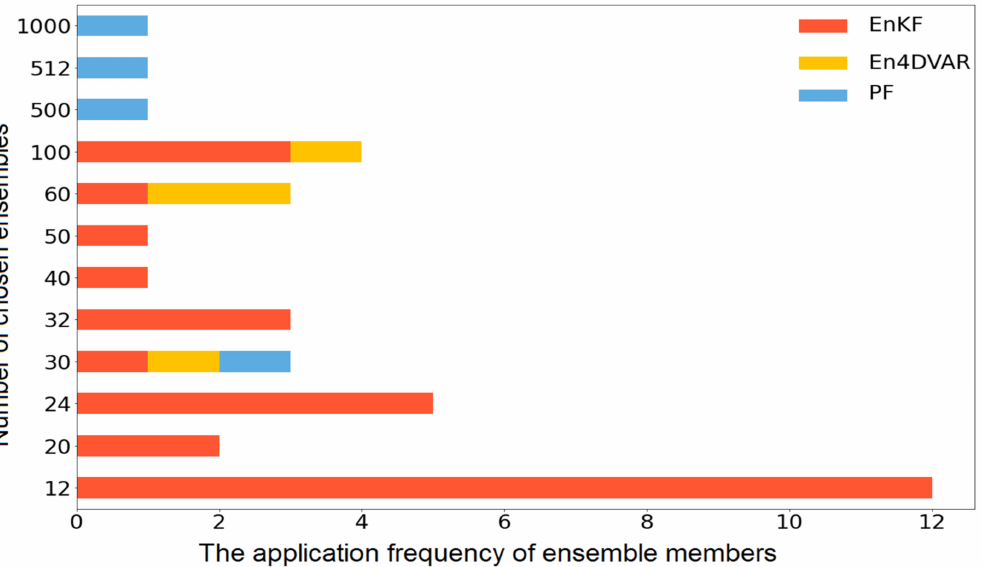
Figure 8. Number of ensembles chosen for EnKF, En4DVAR, and PF methods in the reviewed papers